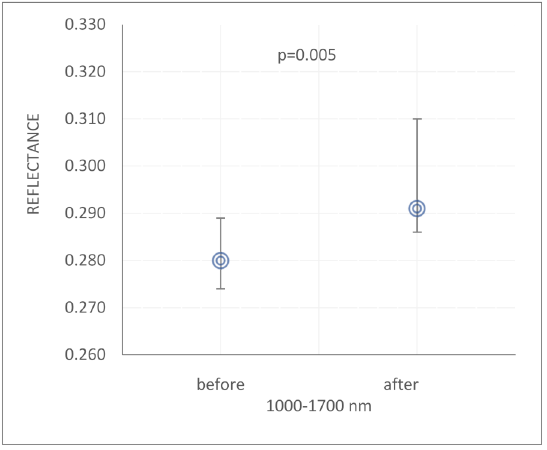
Figure 12. Median and quartile range of reflectance at the wavelength of 1000–1700 nm in the group of women undergoing microdermabrasion, before and after the procedure.